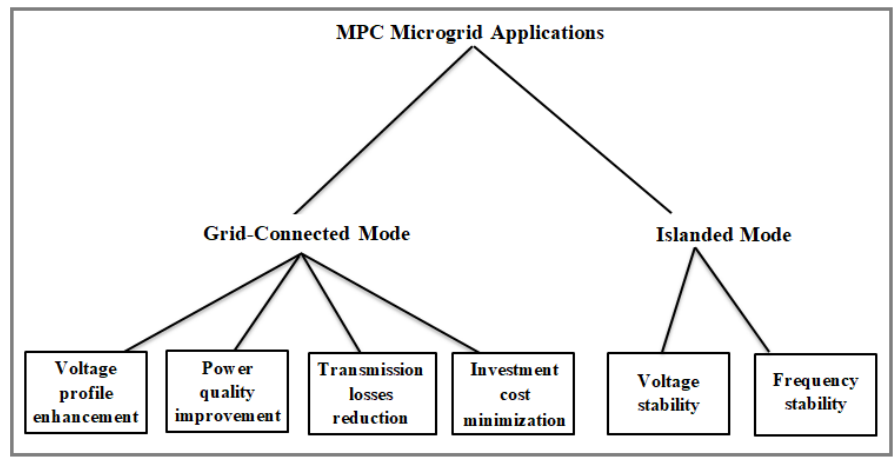
Figure 7. MPC solution approach to MG